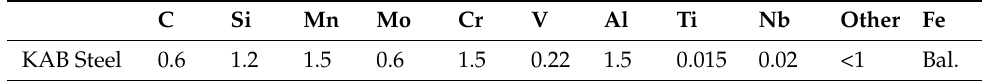
Table 1. Nominal compositions of characterized steels (in wt